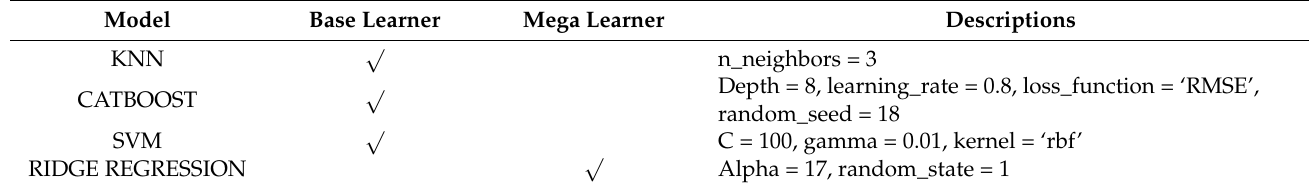
Table 5. The key parameters of four benchmark models in